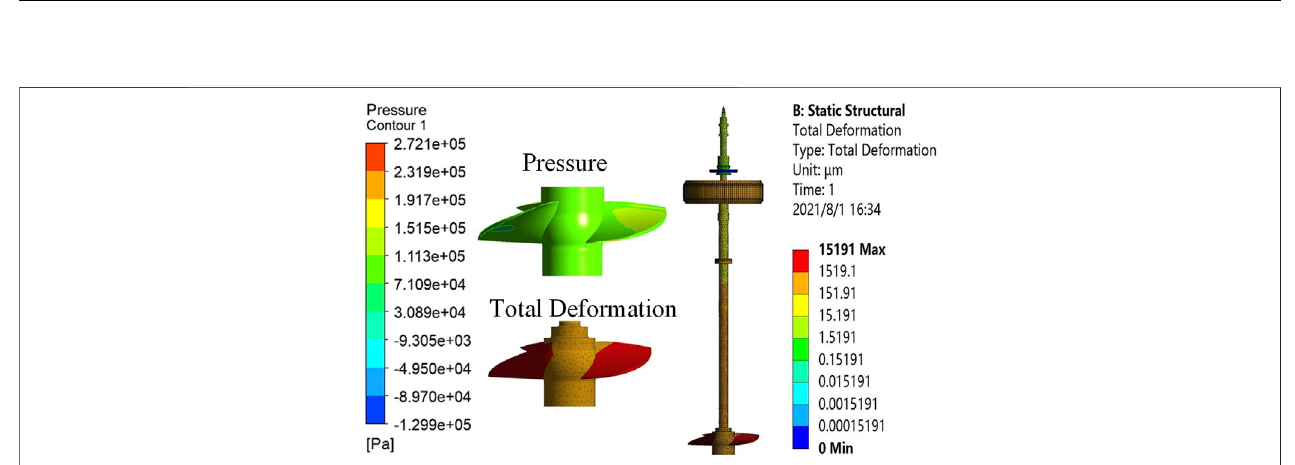
FIGURE 7 | Boundary conditions of rotor model.